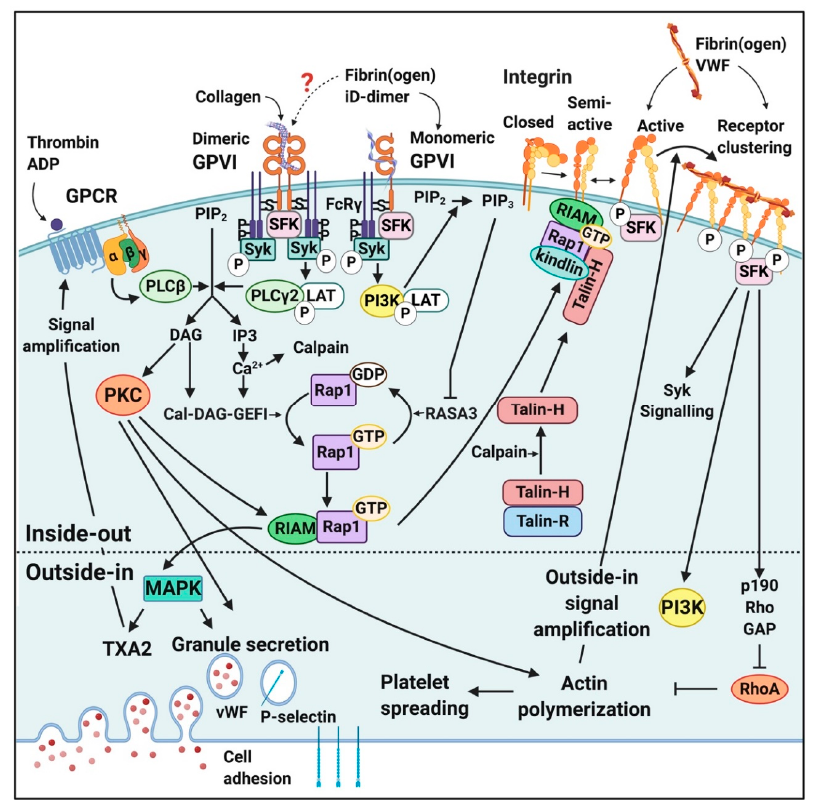
Figure 5. Activation of a platelet, inside-out and outside-in signalling upon ligation of major platelet membrane receptors. Adapted from [40,76,86,90,98]. Abbreviations: GPCR, G-protein coupled receptor; GPVI, glycoprotein VI; VWF, von Willebrand’s factor; PIP2, phosphatidylinositol 4,5-bisphosphate; PIP3, phosphatidylinositol (3,4,5)-trisphosphate; SFK, Scr family kinases; Syk, spleen tyrosine kinase; PLC, phospholipase C; LAT, linker for activation of T-cells; DAG, diacylglycerol; IP3, inositol triphosphate; PKC, protein kinase C; Ca 2+ , calcium ions; Cal-DAG-GEFI, diacylglycerol regulated guanine nucleotide exchange factor I; GDP, guanine diphosphate; GTP; guanine triphosphate; RASA3, Ras GTPase-activating protein 3; RIAM, Rap1-GTP interacting adapter molecule; MAPK, mitogen-activated protein kinase; TXA2, thromboxane A2; GAP, GTPase activating protein; PI3K, phosphatidylinositide 3-kinase. This image was made using BioRender (https://biorender.com/). Fibrinogen binds to endothelial cells (ECs) via the interactions with “intracellular” adhesion molecule 1 (ICAM-1), integrin α V β 1 and integrin α V β 3 [100]. ICAM-1 is an immunoglobulin (Ig)-like adhesion molecule expressed on the membrane of leukocytes and endothelial cells. Extracellularly,